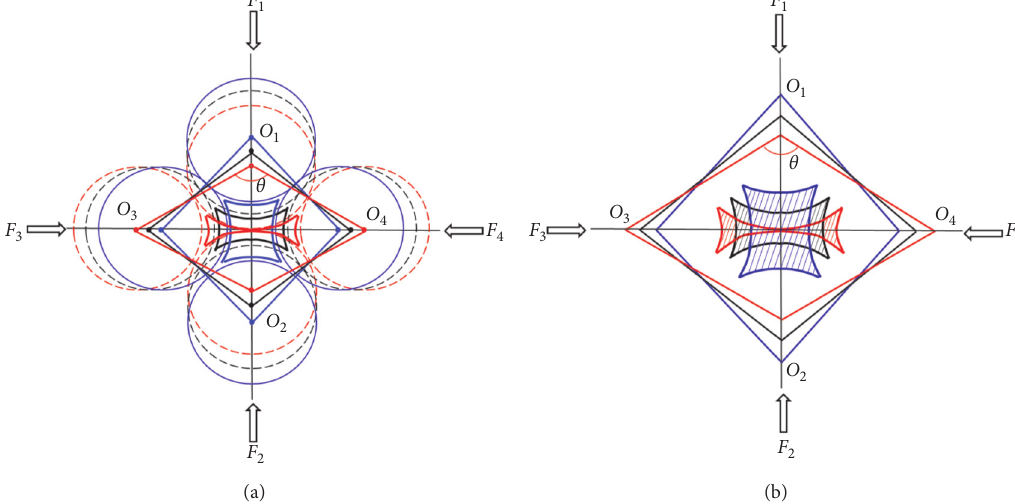
Figure 15: The movement among soil particles. (a) The movement among sand particles. (b) The change of the pore among soil particles.